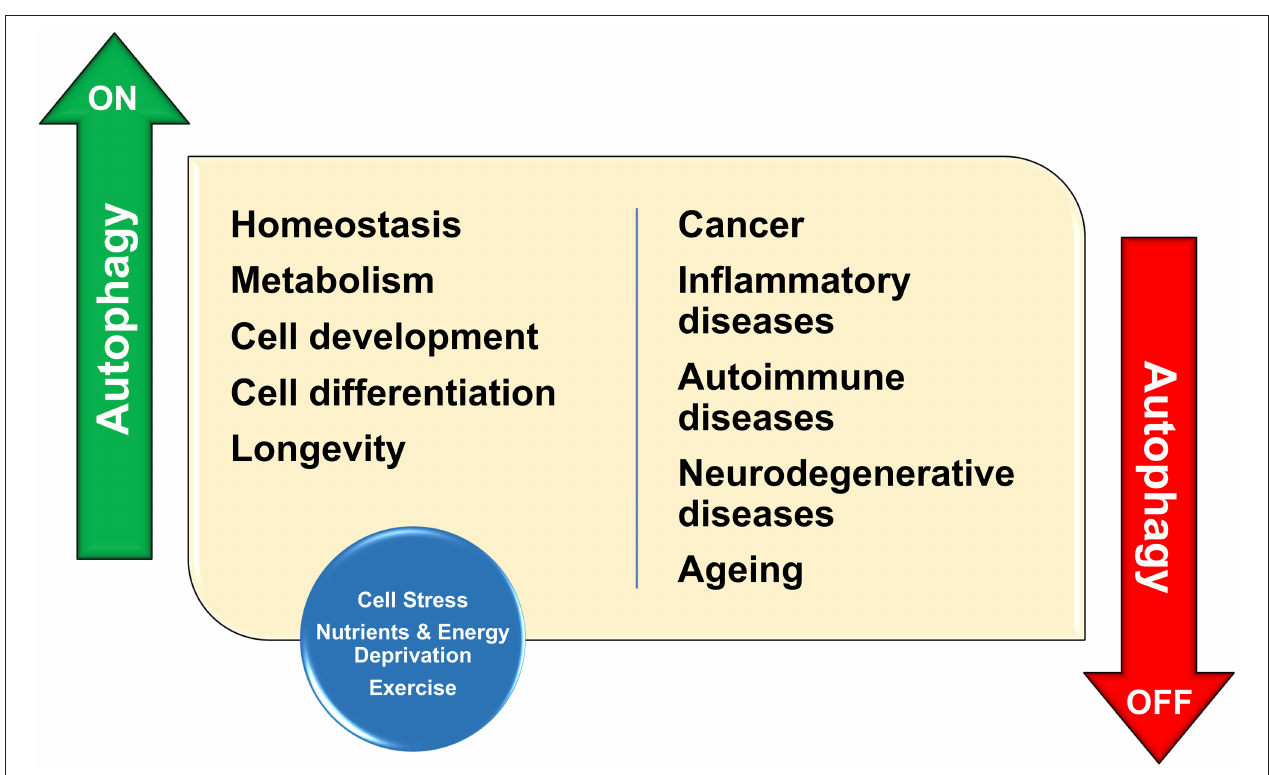
FIGURE 1 | Autophagy has important functions in organelle maintenance, protein turnover, and cellular stress; Therefore, autophagy contributes to the maintenance of cellular homeostasis. As a consequence, any defect in such protective functions would result in the development of many human conditions including cancer, inflammation, and neurodegenerative